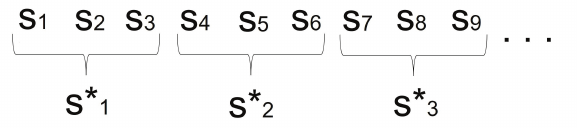
Figure 6. Example of window fusions at score level, for n = 3. s j is the original score (classifier output for each sample window), while s ∗ is the new score as a result of fusing n consecutive original l